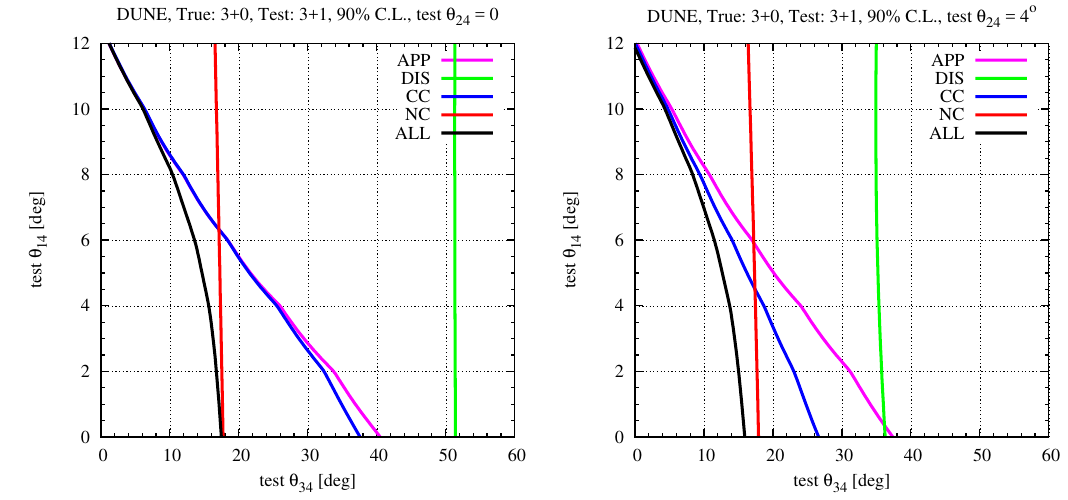
Figure 8 . 90% ((cid:1) (cid:31) 2 = 4 : 61) C.L. contour plots in the test (cid:18) 14 -test (cid:18) 34 plane for di(cid:11)erent choices of test (cid:18) 24 . Left: test (cid:18) 24 = 0 and Right: test (cid:18) 24 = 4 (cid:14) . The true case has been taken to be 3+0 and the test case is 3+1. The value of test (cid:1) m 2 is 1eV 2 for both the plots. The results are for the 41 DUNE experiment with 3.5 years each of neutrino and anti-neutrino running. For these (cid:12)gures, test ( (cid:14) 13 ; (cid:14) 24 ; (cid:14) 34 = (cid:0) 90 (cid:14) ; 0 ; 0) i.e. the (cid:1) (cid:31) 2 has not been marginalised over the test CP phases. We show results for the NC standalone data, appearance standalone data, disappearance standalone data, appearance and disappearance data combined (CC) and (cid:12)nally, the CC and the NC data combined